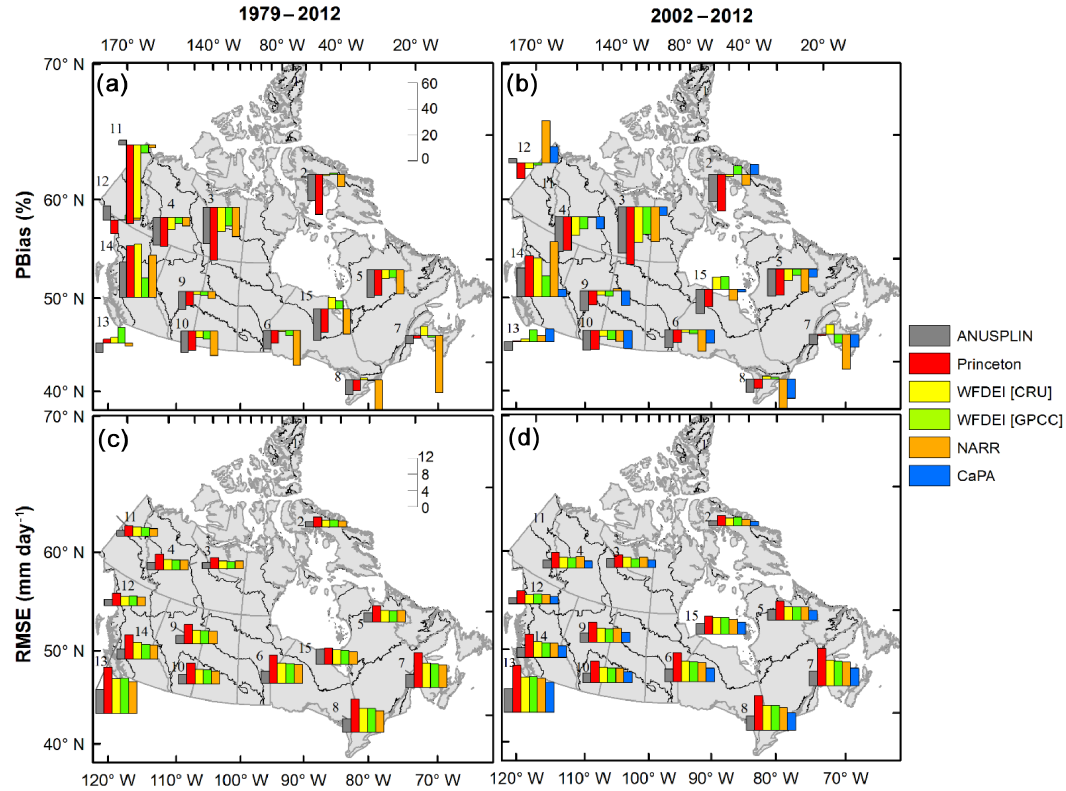
Figure 9. Bar graphs showing the annual accuracy ( P Bias ) (first row) and magnitude of the errors (RMSE) (second row) of each precipitation dataset for the period of 1979 to 2012 (a, c) and 2002 to 2012 (b, d) in different ecozones. The white bar shows the scale of the bars with the number beside it indicating the value of the